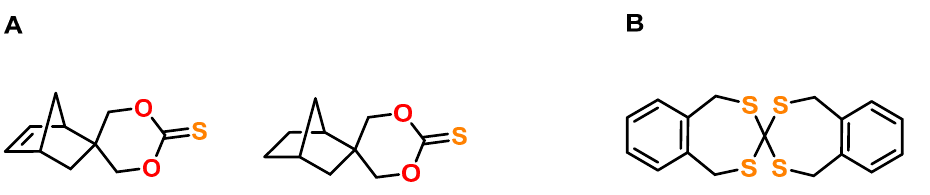
Figure 27. A : Chemical structure of thiocarbonates. B : Chemical structure of a tetrathio-SOC.